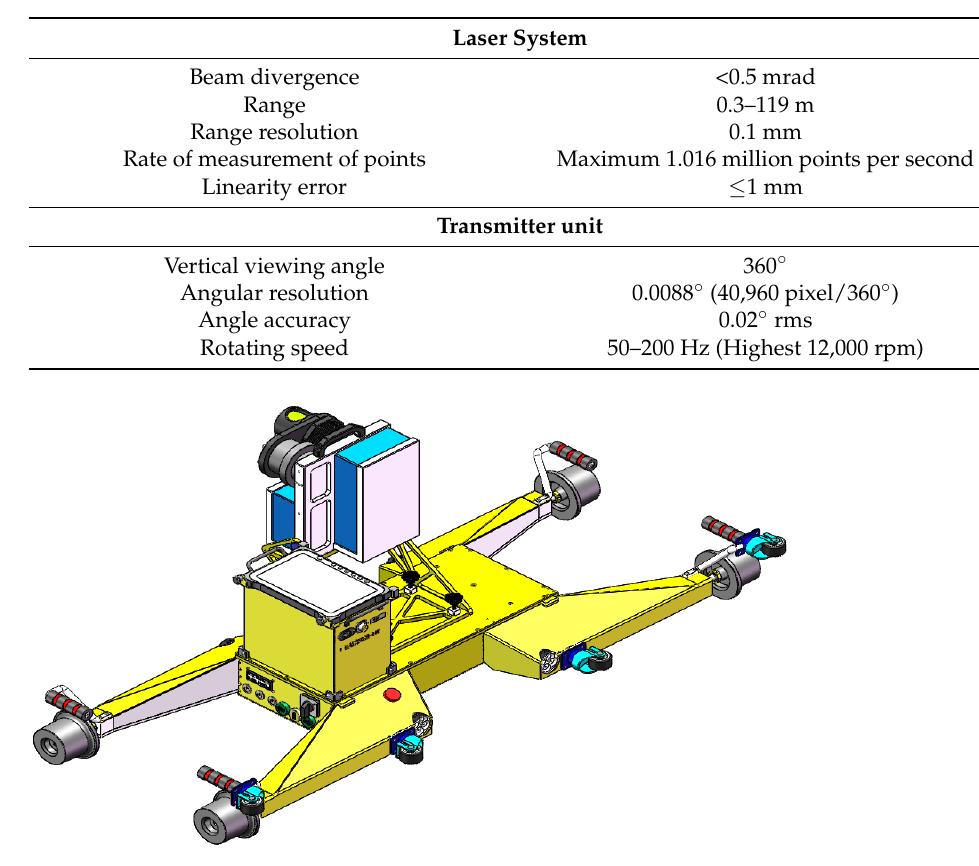
Figure 1. Hardware